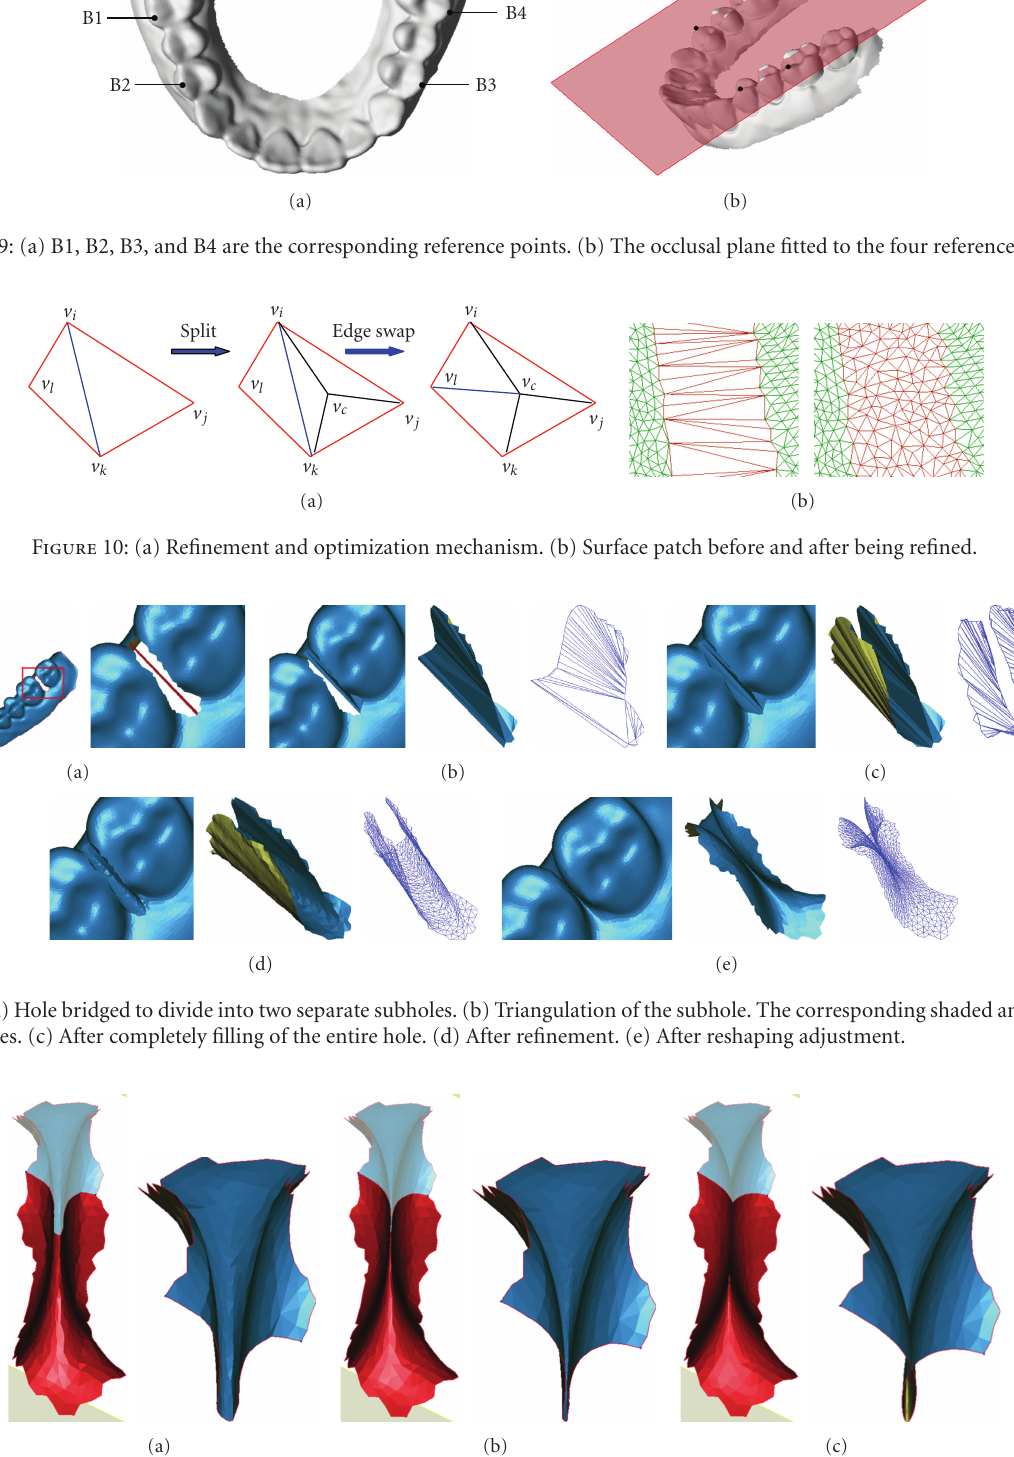
Figure 12: The values of λ determines the deformation degree of the restoration patch. From left to right: the refined mesh patch deformed with λ = 0 . 7, λ = 0 . 85, and λ = 1 .